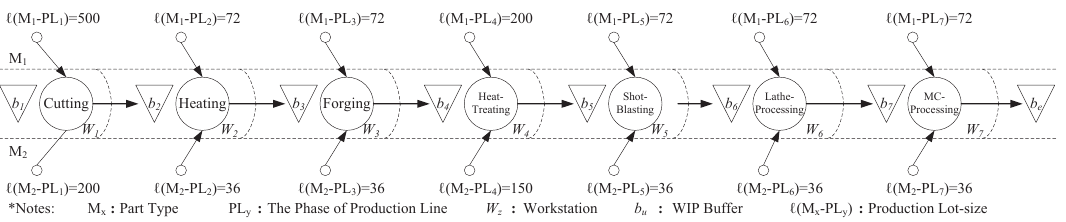
Fig. 4. Logical structure of production line for part types M 1 and M 2 .